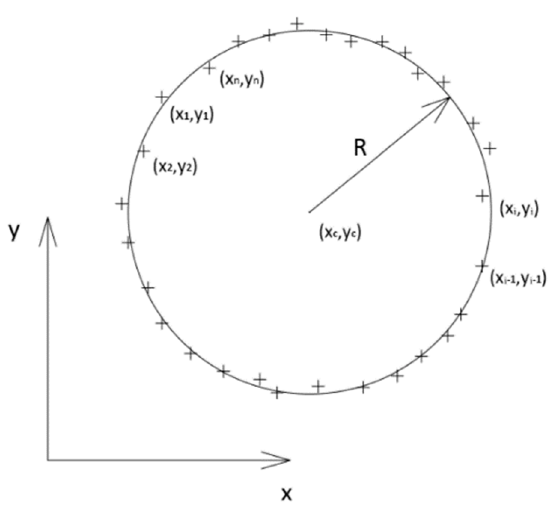
Figure 6. Approximation of the circular cross-section.